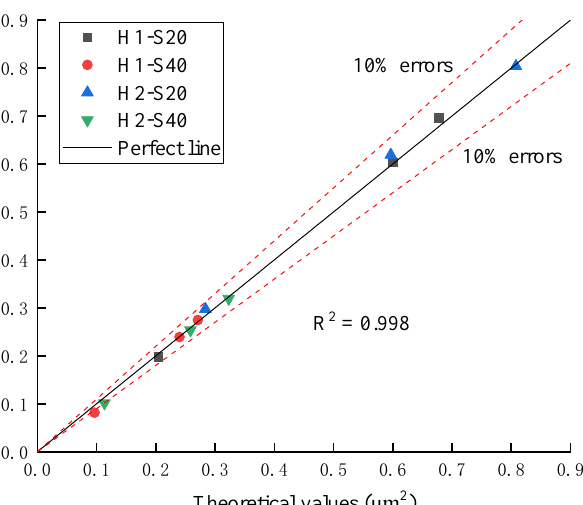
( b ) Figure 19. Relationship between the permeability and porosity of TRC (H1); ( a ) Grid size 20 mm × 20 mm; ( b ) Grid size 40 mm × 40 mm.